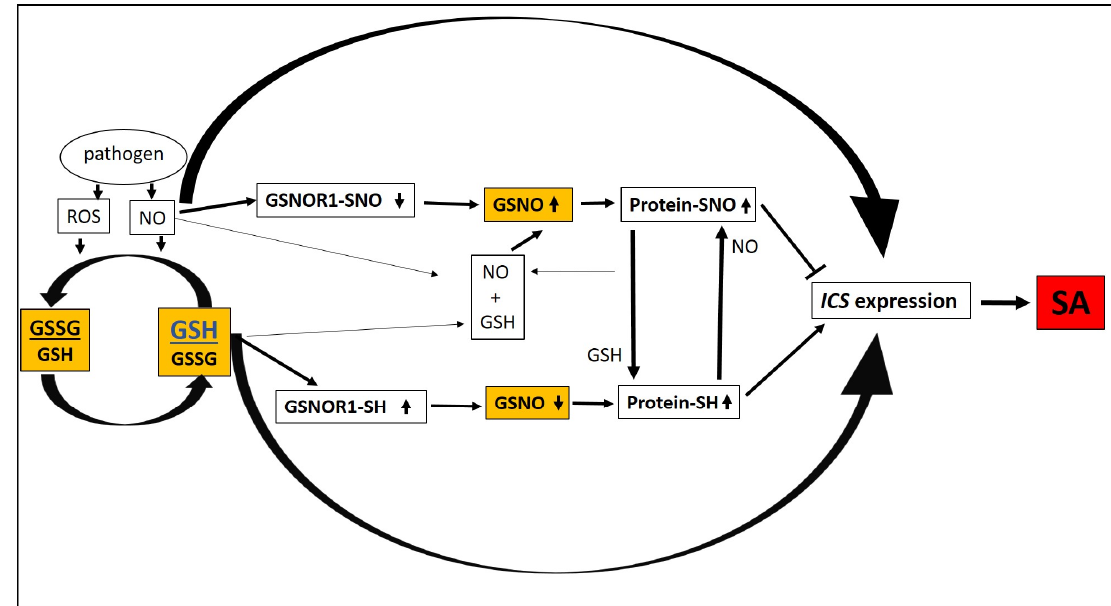
Figure 2. Pathogen induced defense signaling enhances the accumulation of the plant hormone salicylic acid (SA) through the expression of isochorismate synthase ( ICS ) and glutathione (reduced / oxidized form, GSH / GSSG) regulates this process in di ff erent ways. Reactive oxygen species (ROS) and nitrogen oxide (NO) formation during plant defense modulate the GSH / GSSG ratio and ultimately increase GSH levels in resistant plants. GSH and NO may positively modulate SA-dependent gene expression through ICS . GSH activates S -nitrosoglutathione reductase 1 (GSNOR1) that catalyzes the degradation of S -nitrosoglutathione (GSNO). GSNO degradation leads to a reduction in protein-SNO formation, therefore, protein-SH groups remain intact, activating enhanced ICS expression and SA synthesis. NO inactivates GSNOR1, leading to GSNO accumulation, protein-SNO formation and repression of ICS expression. In contrast, GSH can react with protein-SNOs to form protein -SH groups leading to enhanced ICS expression, SA accumulation and plant defense. Furthermore, not only the NO derived from the reduction in protein-SNOs but also NO accumulating during initial stages of plant defense to pathogens can react with GSH to form GSNO, which will repress SA accumulation and plant defense.